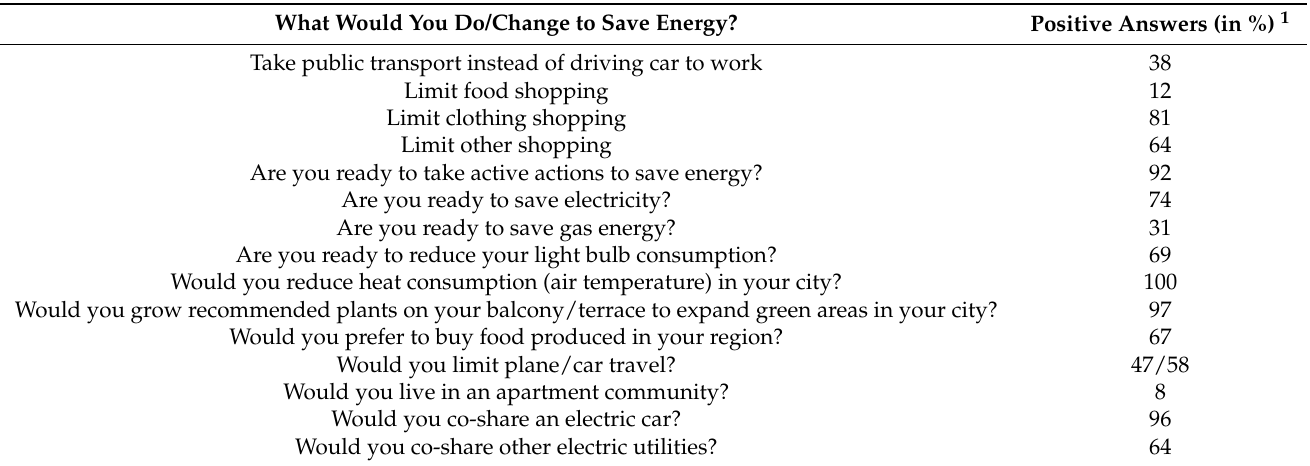
Table 1. The respondents view (%) on energy